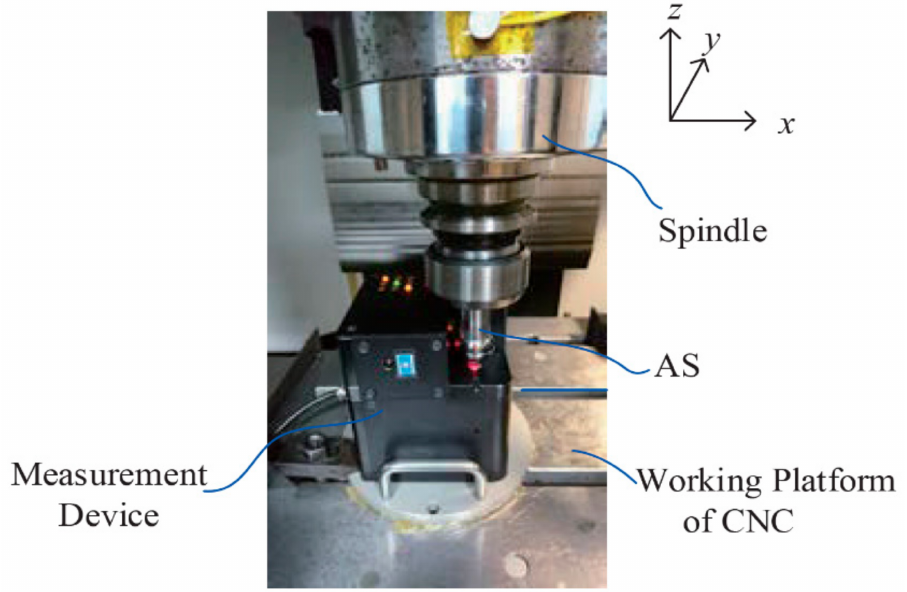
Figure 41. Setup for spindle error motion measurement [33].